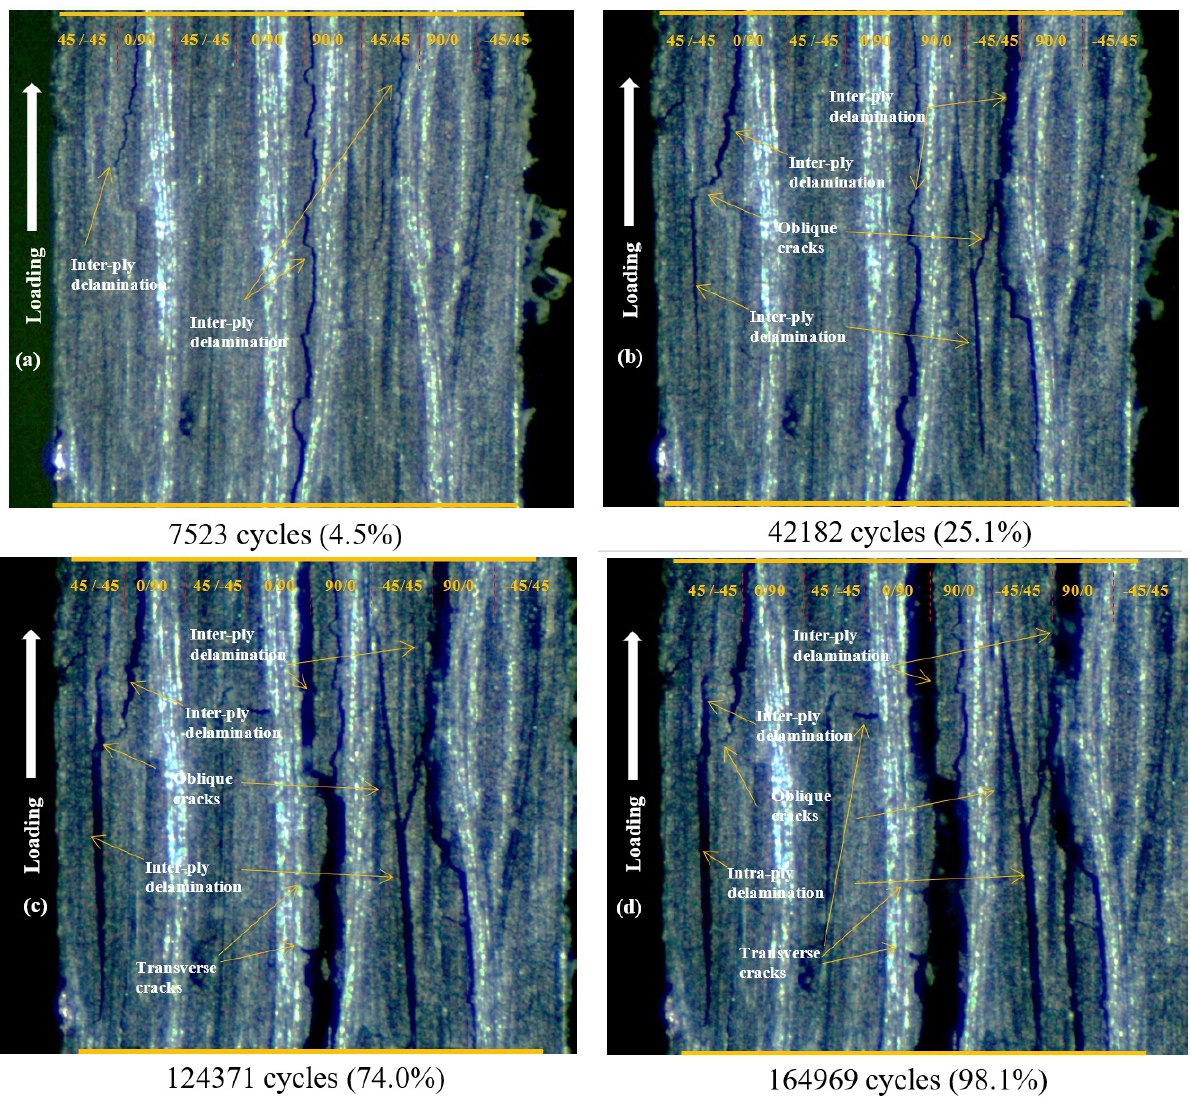
Figure 10: View of the tension-tension fatigue of no-damaged specimens under 70%UTS (a) at 7523 cycles (4.5% of the life); (b) at 42182 cycles (25.1% of the life); (c) at 124371 cycles (74.0% of the life); (d) at 164969 cycles (98.1% of the life)